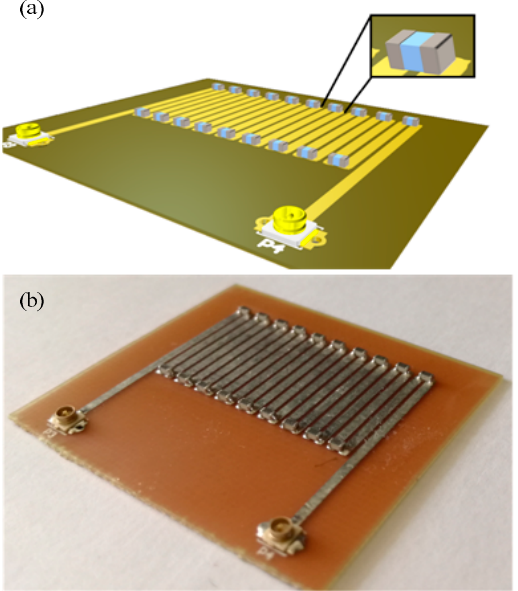
Figure 8. The hybrid meander system: ( a ) PCB model and ( b ) manufactured prototype (zoomed image).